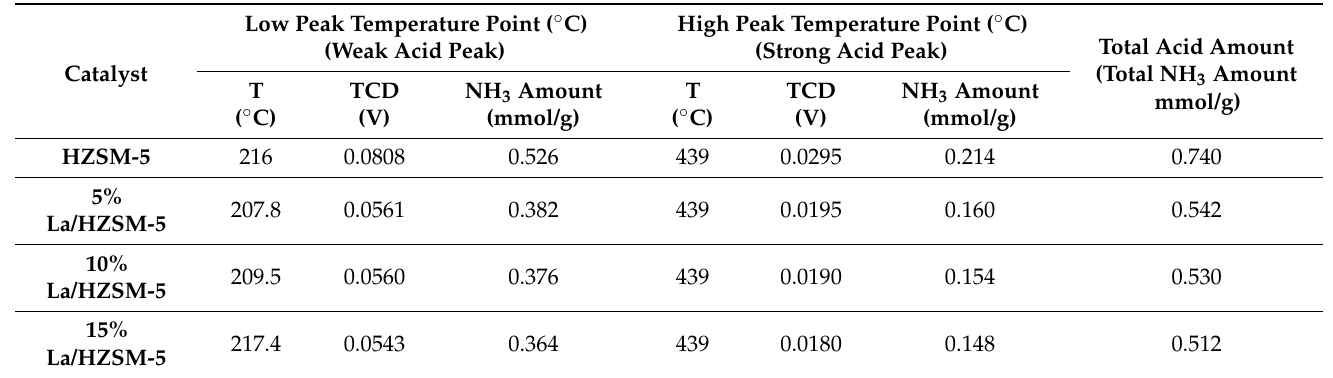
Table 2. NH 3 -TPD properties of HZSM-5, 5%La/HZSM-5, 10%La/HZSM-5, and 15%La/HZSM-5.